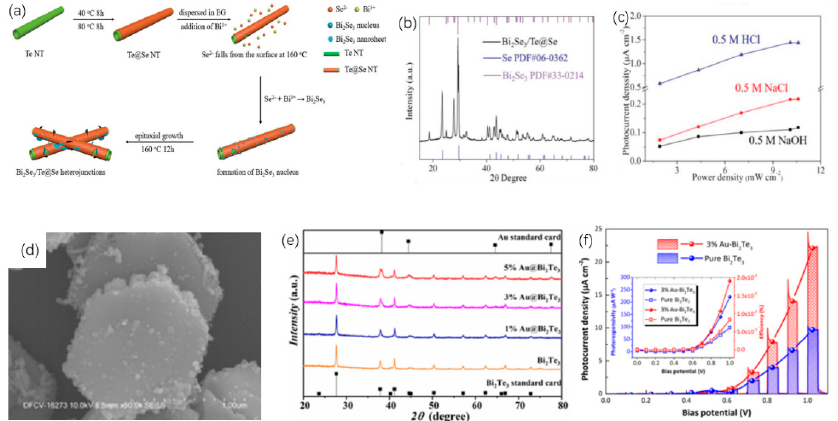
Figure 29. ( a ) Flow chart of Bi 2 Se 3 /Te@Se preparation. ( b ) X-ray diffraction spectra of several materials. ( c ) The light response intensity curve of Bi 2 Se 3 /Te@Se in different alkaline solutions [329]. Copyright2019 Wiley-Blackwell. ( d ) SEM image of 3% Au-Bi 2 Te 3 . ( e ) X-ray diffraction spectra of pure Bi 2 Te 3 and Au-Bi 2 Te 3 of different concentrations. ( f ) Curve of photocurrent with the change of bias voltage [331]. Copyright 2020 Elsevier Ltd.